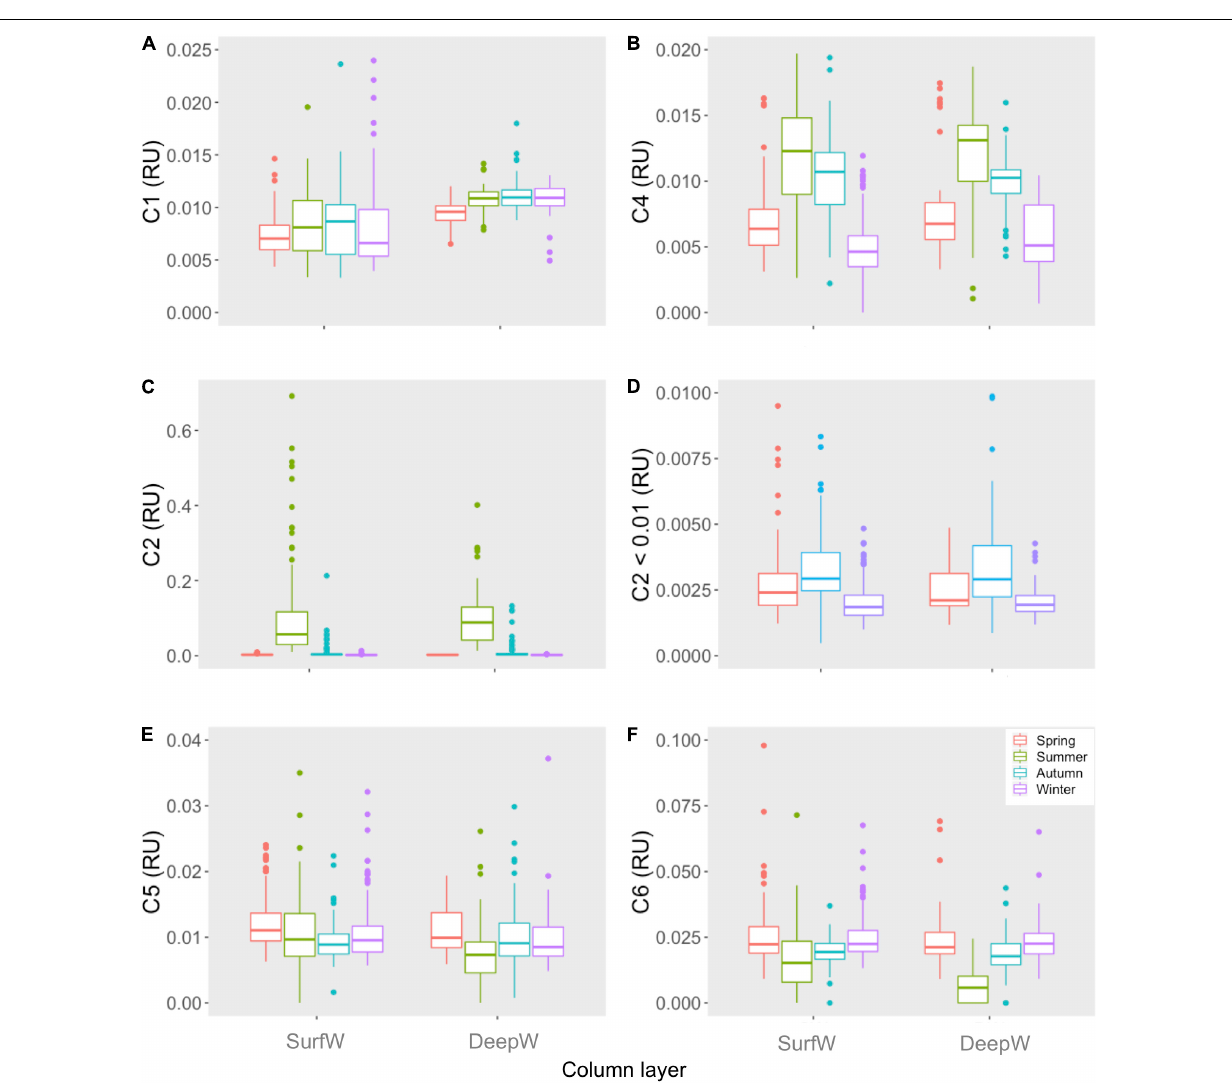
FIGURE 3 | Average intensities of PARAFAC components- (A) : C1, (B) : C4, (C,D) : C2, (E) : C5 and (F) : C6- for each season at surface water (SurfW) and deep water (DeepW) in the Gulf of